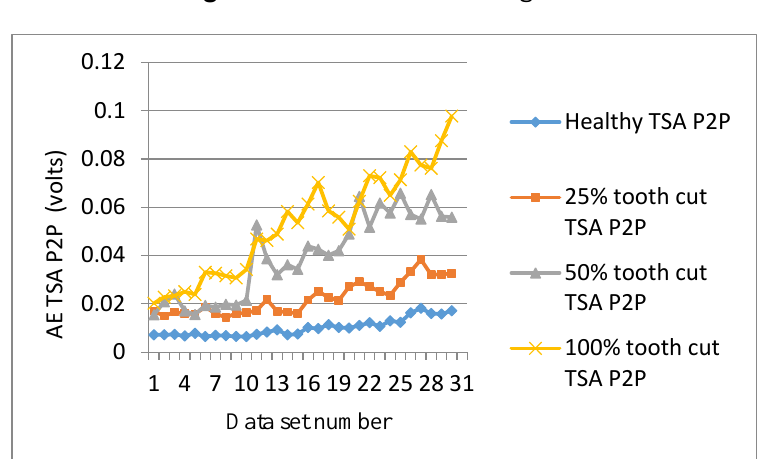
Figure 9. P2P of AE TSA